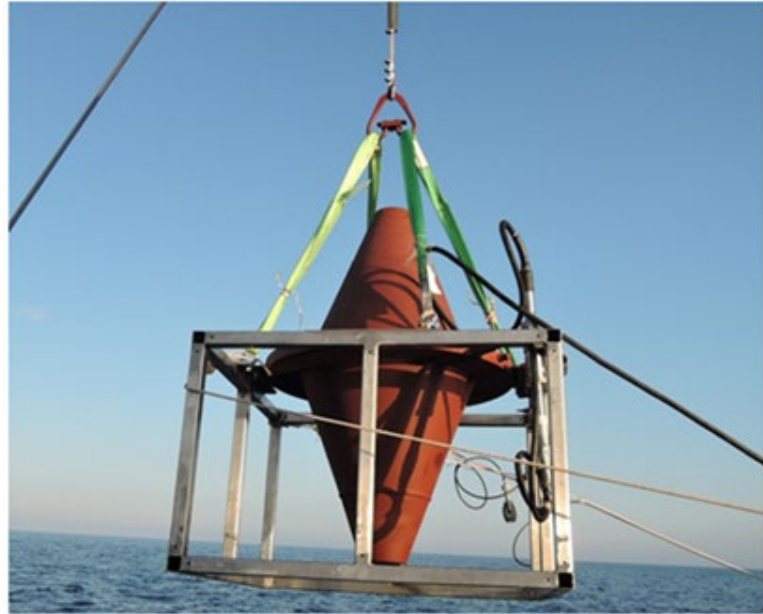
Figure 4. Bicone broadband source.